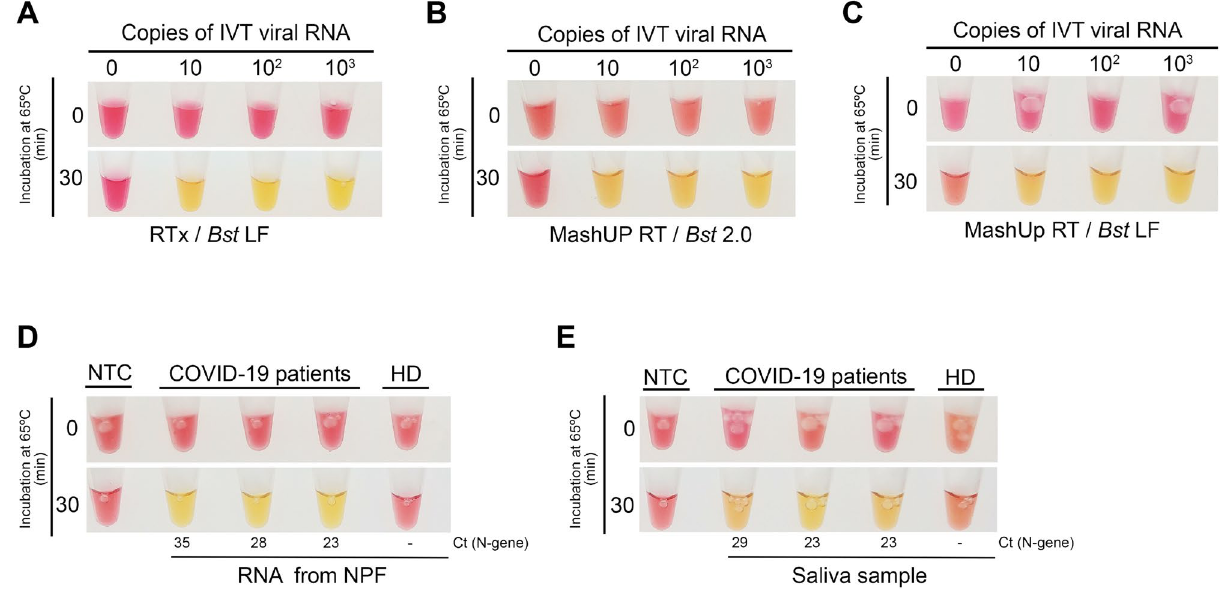
Figure 5. Analytical sensitivity of an in-house-made colorimetric RT-LAMP assay. Tenfold dilutions of in vitro transcribed (IVT) viral RNA (N-gene) were amplified via RT-LAMP and detected using a colorimetric buffer together with ( A ) RTx (New England Biolabs) and Bst LF (homemade), ( B ) MashUP RT (homemade) and Bst 2.0 (New England Biolabs) or ( C ) MashUP RT (homemade) and Bst LF (homemade). The in-house-made setup was next used to detect SARS-CoV-2 sequences in ( D ) RNAs extracted from the NP fluid (NPF) and ( E ) saliva samples of COVID-19 positive patients. The reactions were incubated at 65 °C for 30 min. In ( D ) and ( E ) the Cts (N gene) obtained for the paired NP samples are indicated. NTC no template control, HD healthy donor. Figures are representative of three independent (CI 70–93%) for saliva samples with matched NP swabs with Ct ≤ 28 (Fig. 4C). Reaction volumes, but not saliva amounts, were scaled up to increase the assay sensitivity (Fig. 4B).